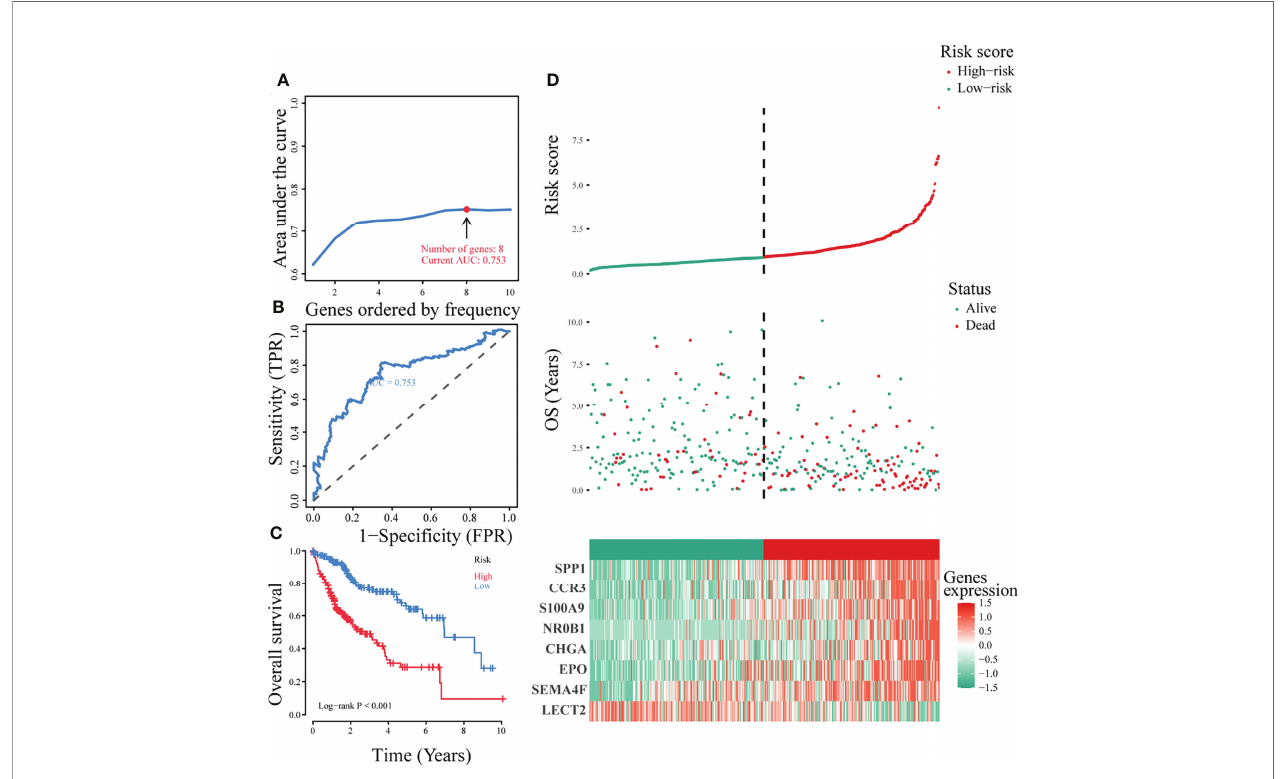
FIGURE 3 | Construction of the optimal immune gene signature associated with LIHC prognosis. (A) Iterative Lasso Cox regression analysis used to construct the immune gene signature based on the size of the AUC. (B) ROC analysis of the optimal immunity-associated gene signature. (C) Kaplan-Meier curves of different risk groups. (D) The risk factor association diagram showing risk score distribution, survival status, and expression of the signature genes in the two risk